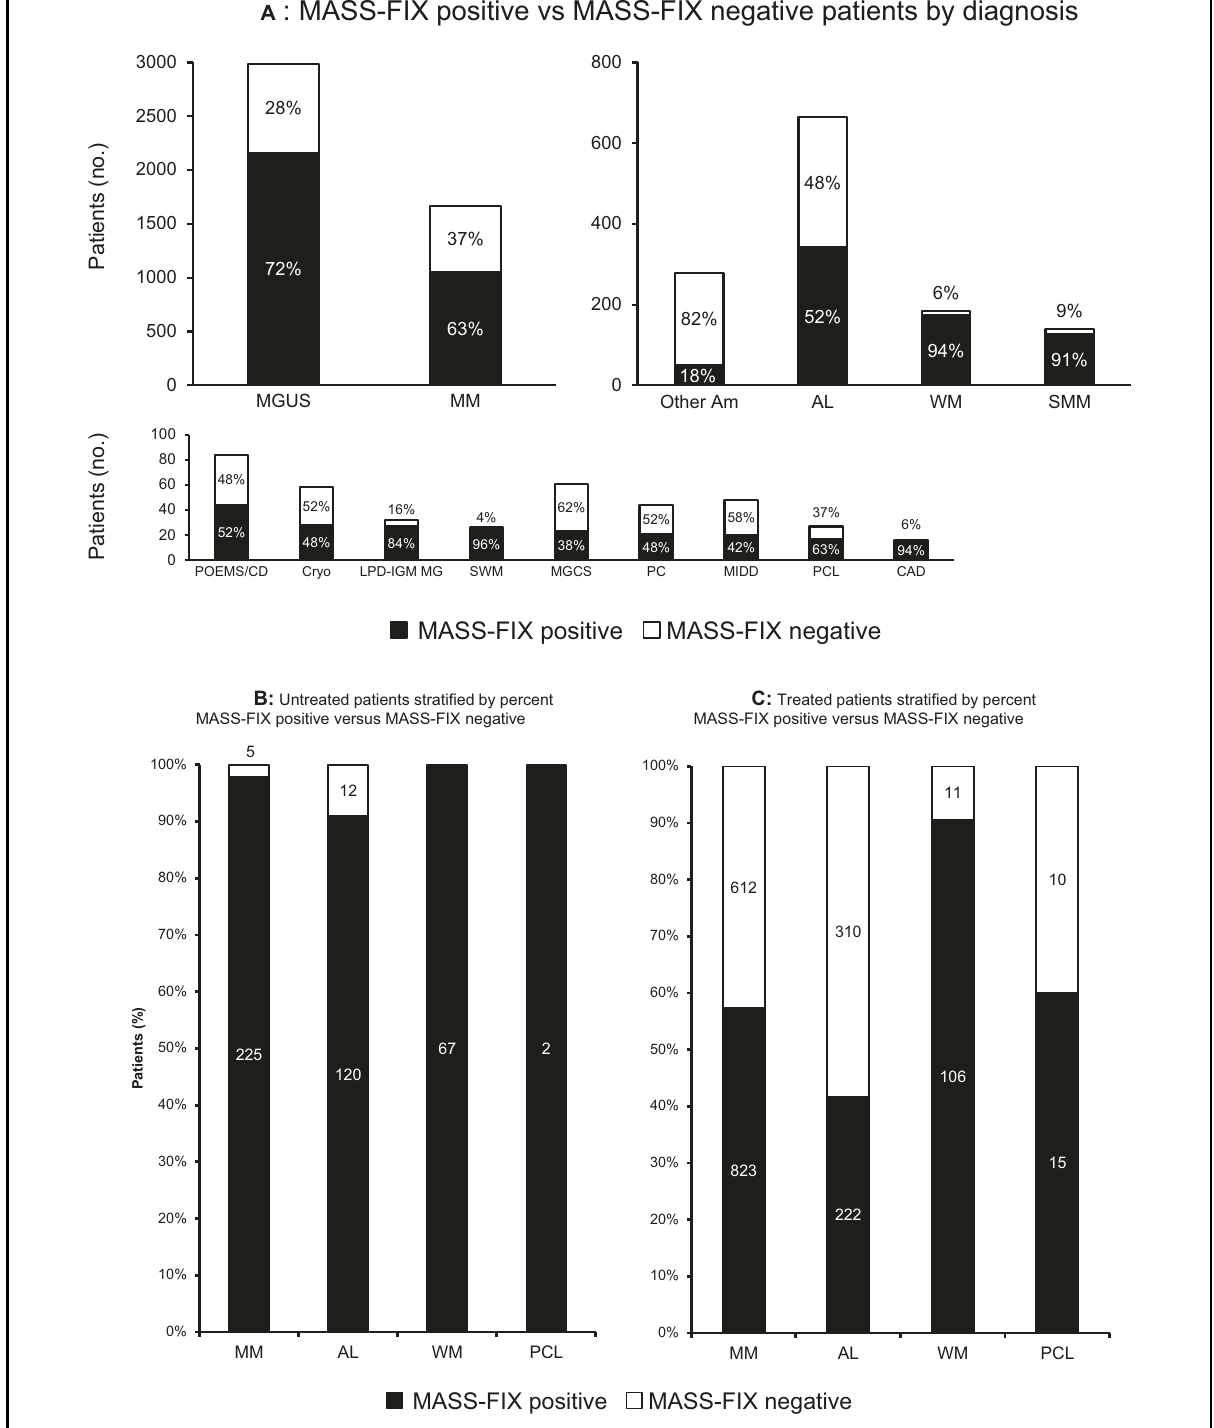
Fig. 2 A MASS-FIX positive vs. MASS-FIX negative patients by diagnosis. MGUS monoclonal gammopathy of undetermined signi fi cance, MM multiple myeloma, Other Am other amyloidosis, AL immunoglobulin light chain amyloidosis, WM Waldenstrom ’ s macroglobulinemia, SMM smoldering multiple myeloma, POEMS/CD POEMS/Castleman ’ s disease, Cryo cryoglobulinemia, LPD-IGM MG lymphoproliferative disorder with monoclonal gammopathy, SWM smoldering Waldenstrom ’ s macroglobulinemia, MGCS monoclonal gammopathy of clinical signi fi cance, PC plasmacytoma, MIDD monoclonal immunoglobulin deposition disease, PCL plasma cell leukemia, CAD cold agglutinin disease. Note that MASS-FIX positive other amyloidosis has an associated MGUS. B Untreated patients strati fi ed by percent MASS-FIX positive versus MASS-FIX negative. C Treated patients strati fi ed by percent MASS-FIX positive versus MASS-FIX negative. MM multiple myeloma, AL immunoglobulin light chain amyloidosis, WM Waldenstrom ’ s macroglobulinemia, PCL plasma cell